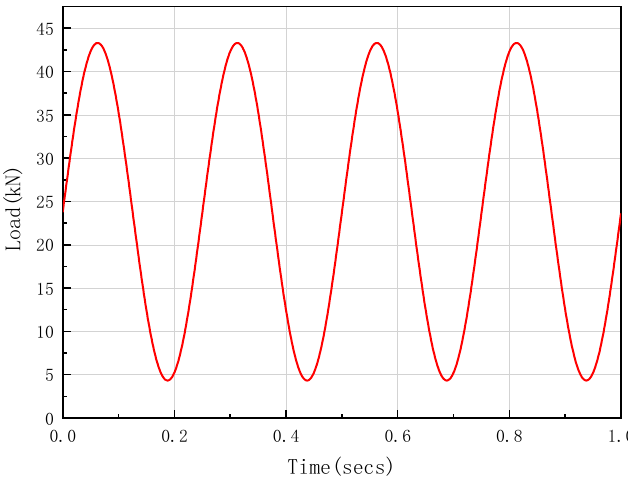
Figure 17. Load spectrum for fatigue testing of the expansion joint.